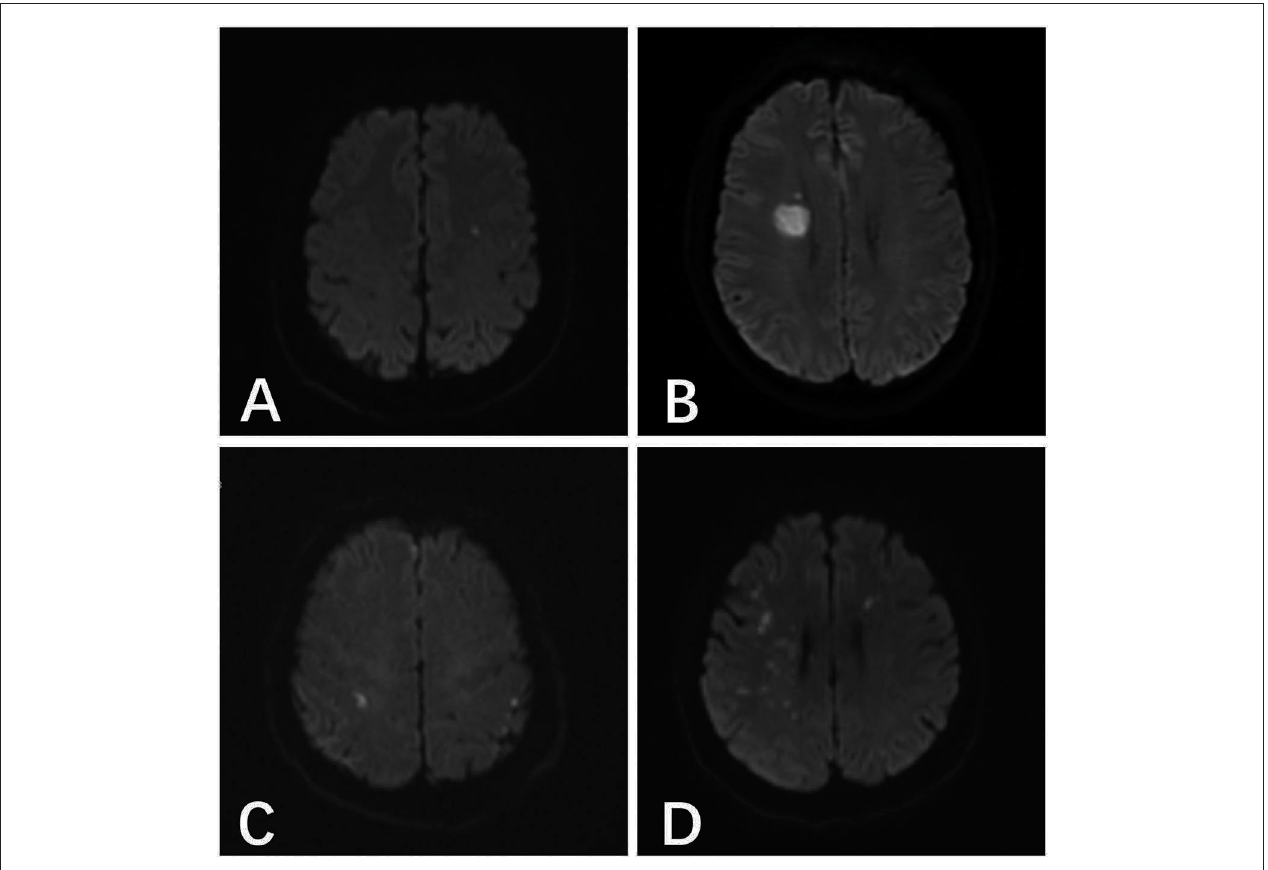
FIGURE 1 | (A) A 46-year-old male patient with anterior communicating aneurysm underwent pure spring coil embolization under systemic heparinization, and the postoperative result indicated the acute cerebral infarction focus in the left parietal temporal lobe. (B) A 48-year-old male patient with right posterior communicating aneurysm underwent stent-assisted embolization under local heparinization, and the postoperative result indicated the acute cerebral infarction in the right lateral ventricle. (C) A 54-year-old male patient with right posterior communicating aneurysm underwent pure spring coil embolization under local heparinization, and the postoperative result indicated the abnormal DWI signals in the bilateral parietal lobes. (D) A 55-year-old female patient with a right middle cerebral aneurysm underwent stent-assisted embolization under systemic heparinization, the postoperative result indicated the acute cerebral infarction in the right parietal temporal lobe and the left frontal